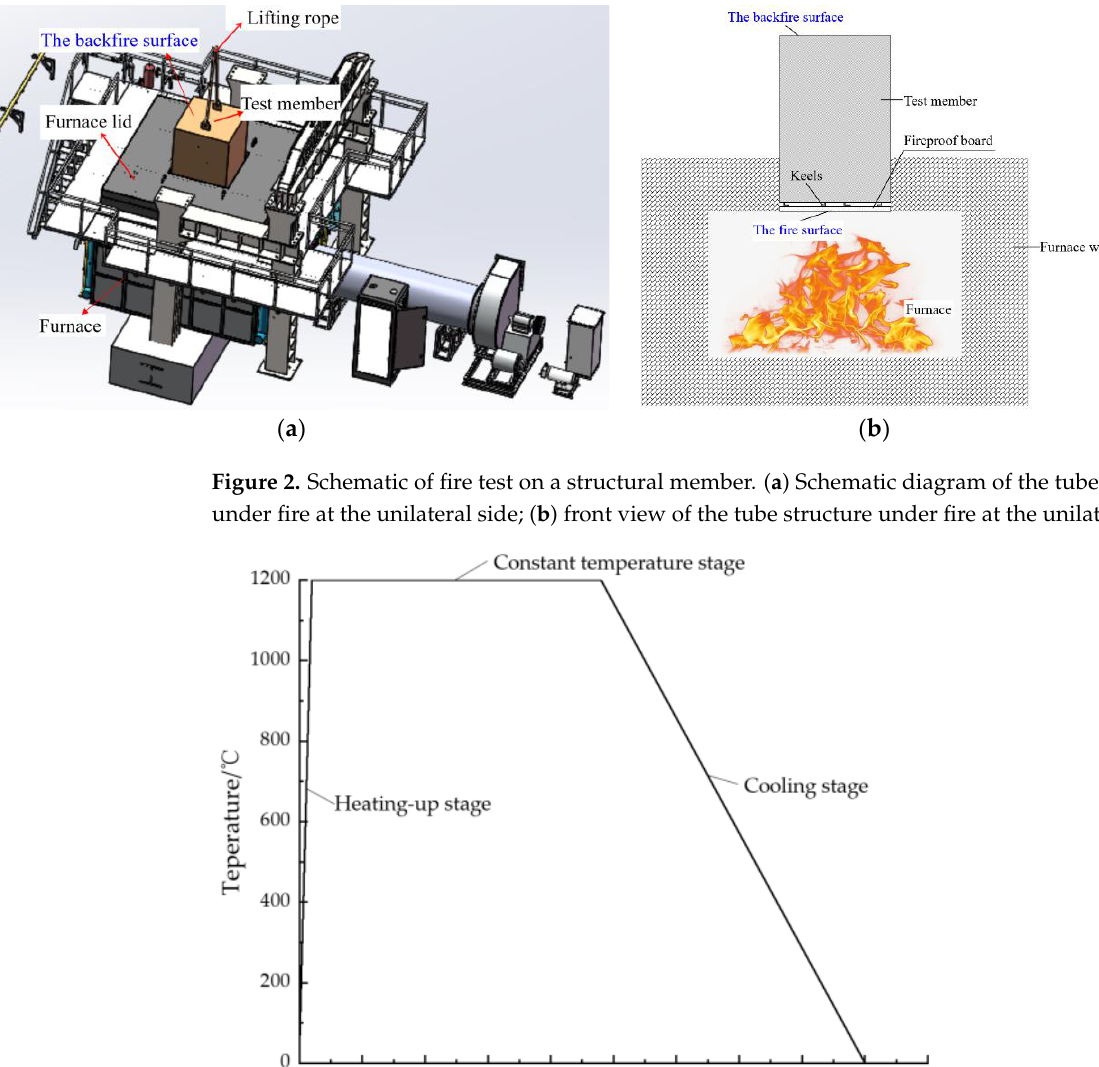
Figure 3. RABT tunnel fire heating curve.